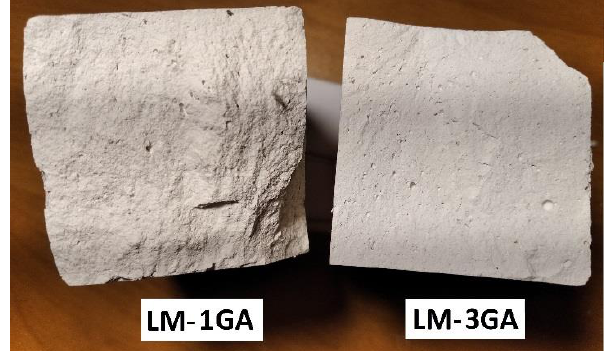
Figure 16. Fracture surface of the samples after the flexural strength test.